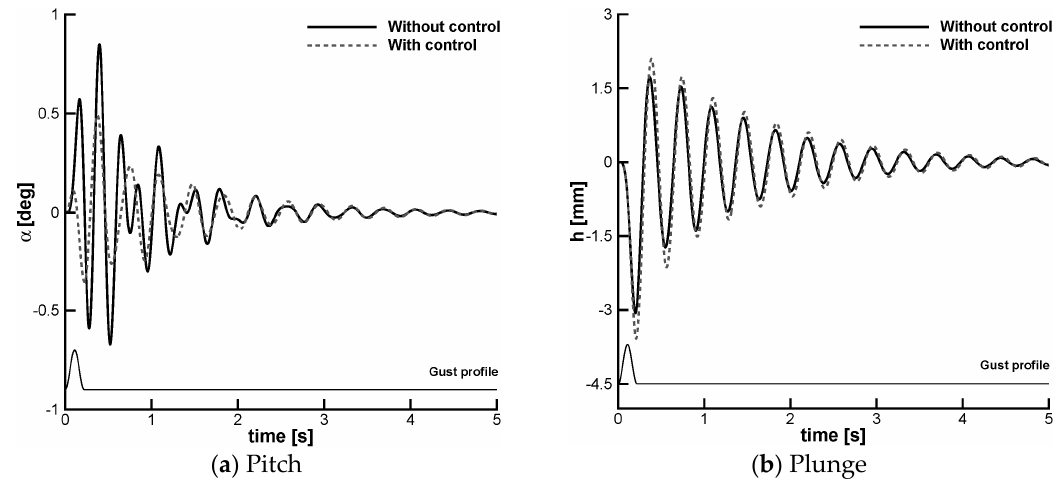
Figure 10. Aeroelastic response due to the worst-case “one-minus-cosine” gust with and without control ( H = 3.5 m, U ds = 0.8 m/s, U ∞ = 8.0